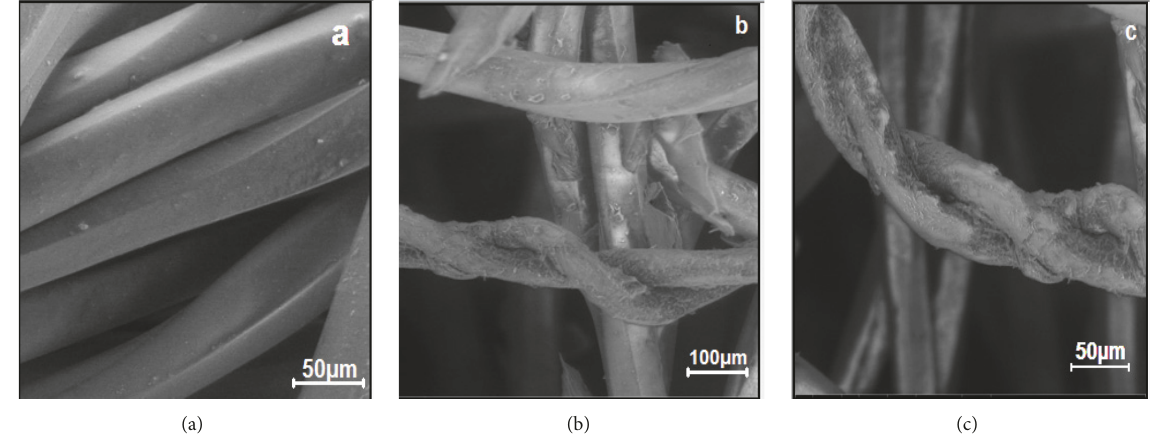
Figure 10: SEM micrographs of (a) untreated PAfs and (b, c) treated